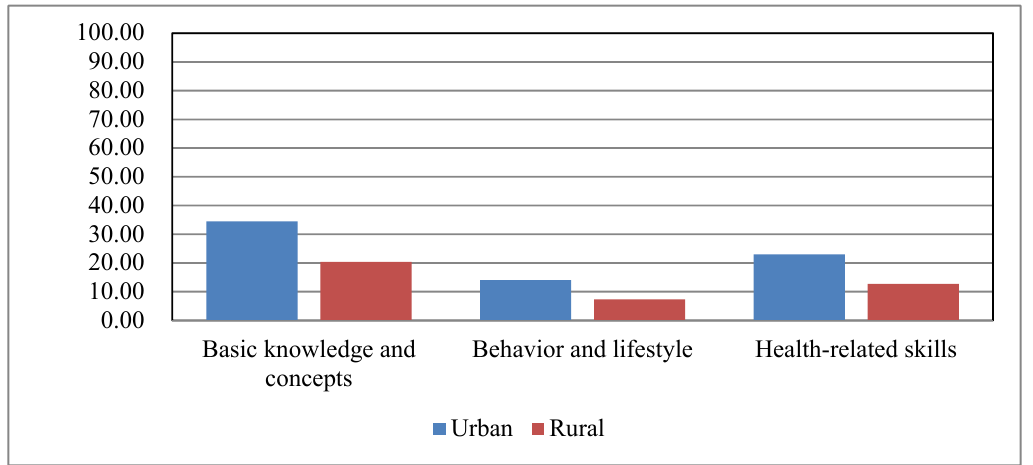
Figure 3. The level of health literacy in 3 different aspects (i.e., basic knowledge and concepts, healthy behavior and lifestyle, and health-related skills) in urban and rural populations.